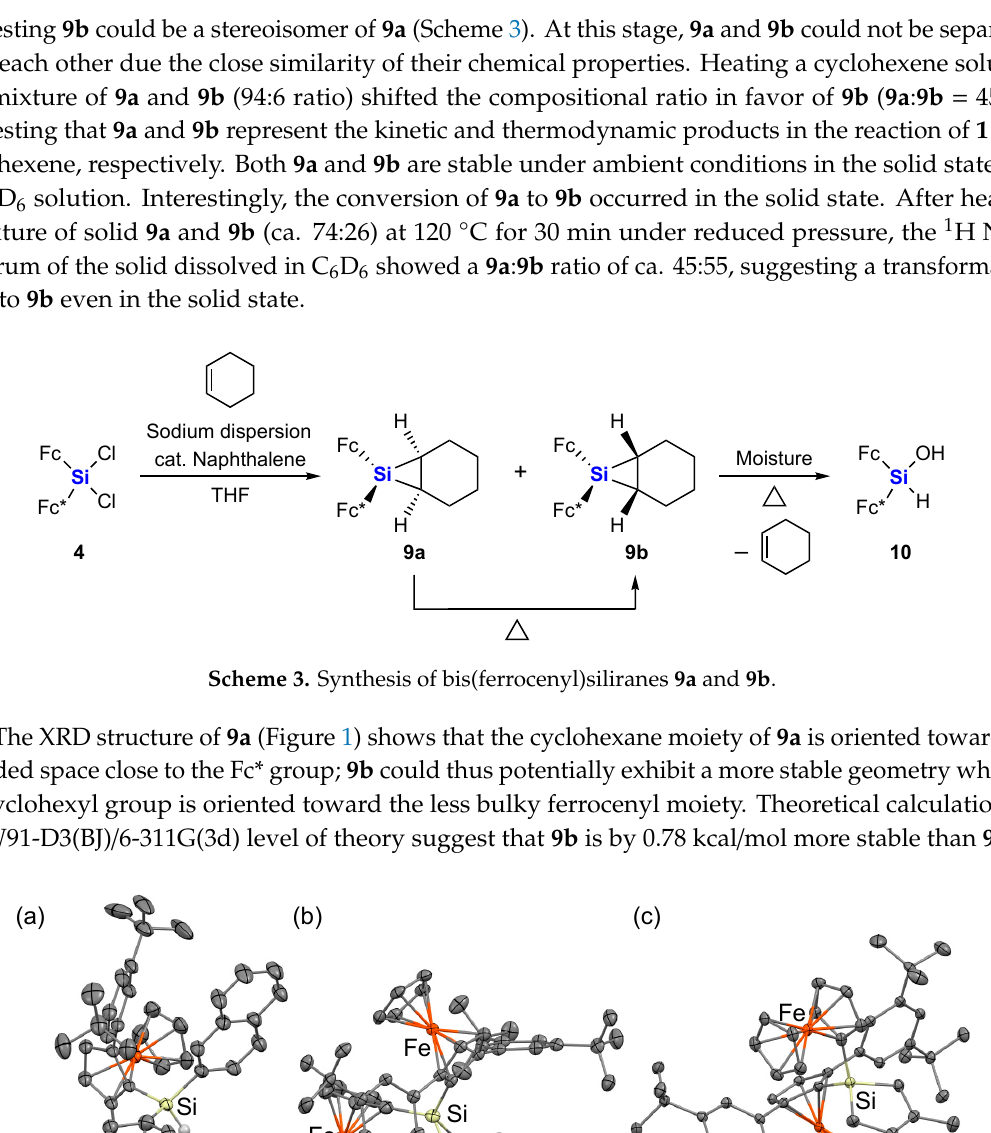
Figure 1. Molecular structures of ( a ) 5 , ( b ) 9a , and ( c ) 14 with thermal ellipsoids at 50% probability; hydrogen atoms other than that of the Si-H moiety are omitted for clarity.